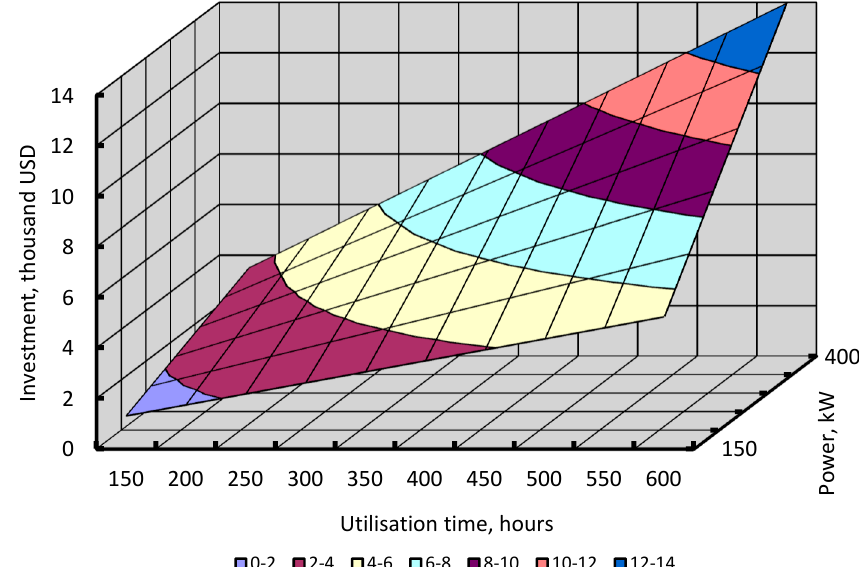
Figure 9. Maximum electric turbocompounding system cost (simple payback period—5 years). Source: developed by authors.